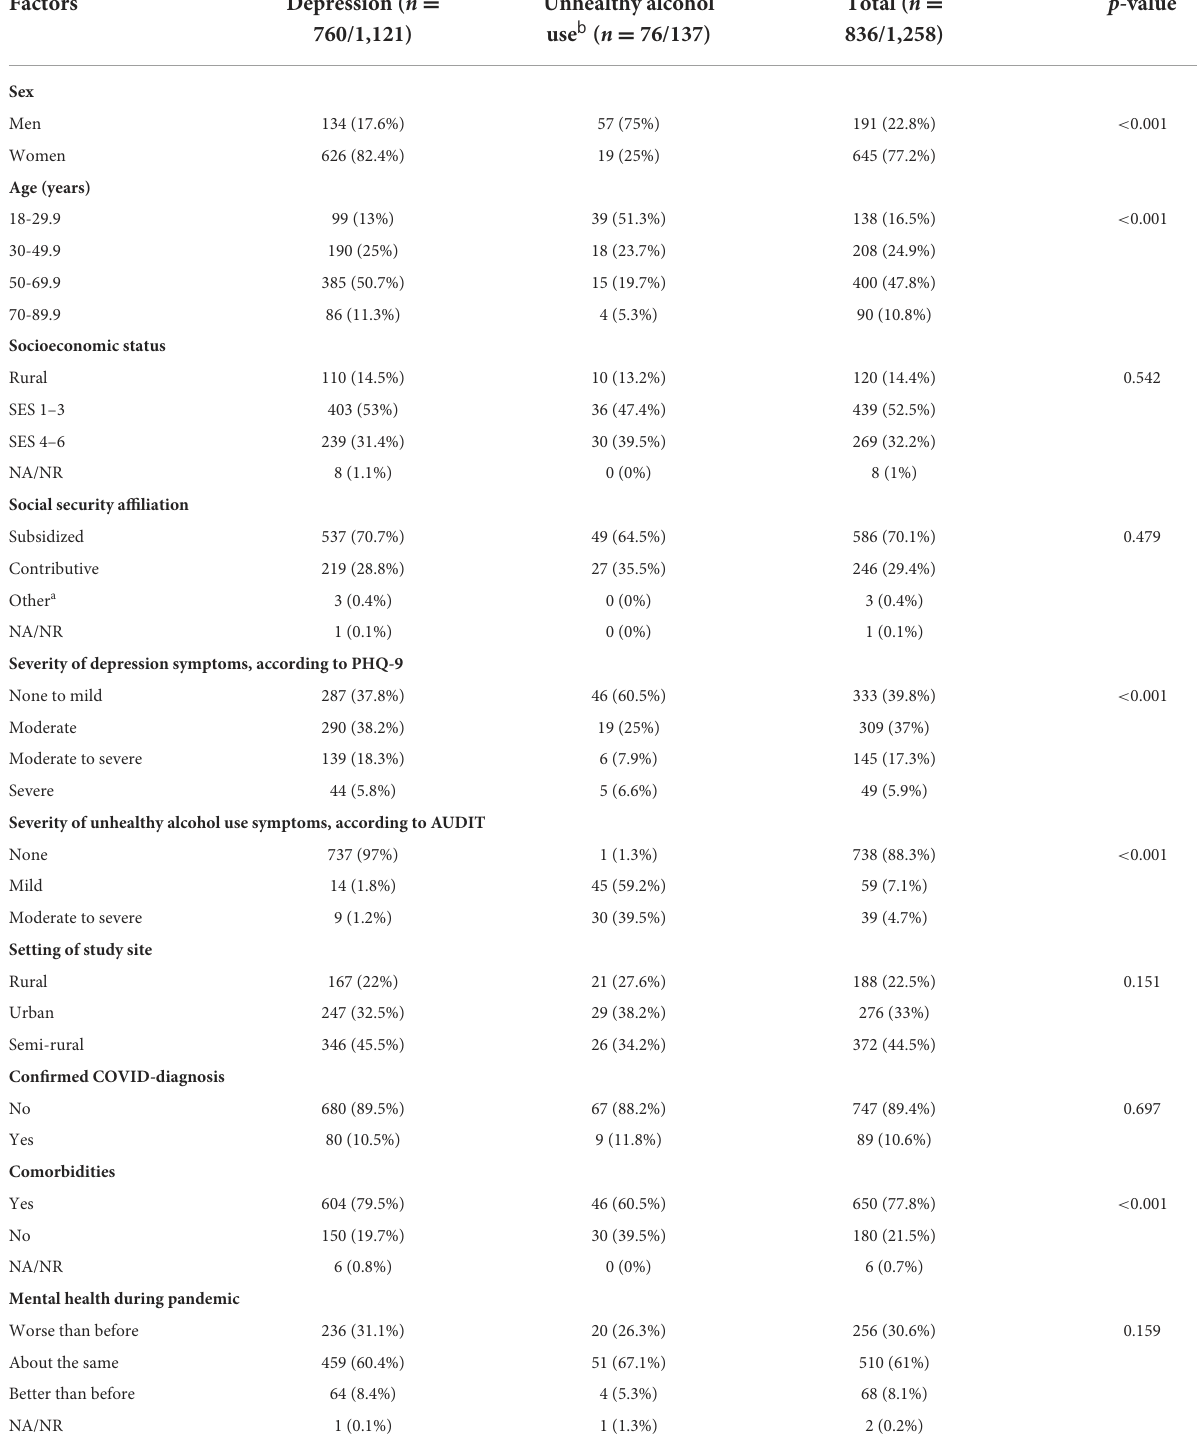
TABLE 1 Characteristics of the study population, according to baseline